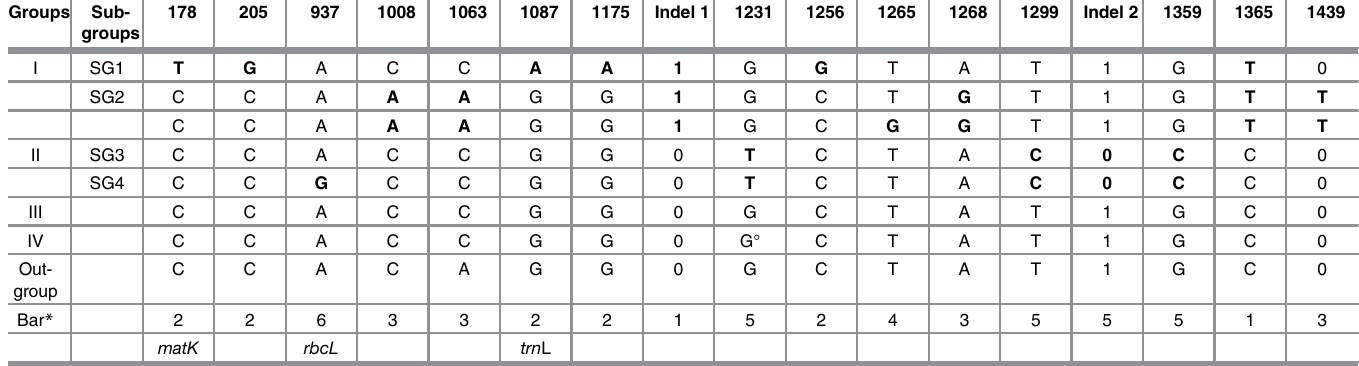
Table 2. Diagnostic polymorphisms for the identification of Malagasy Dalbergia based on DNA sequence variation in the plastid genes mat K, rbc L and trn L (UAA). In bold are diagnostic polymorphisms that distinguish Malagasy from non-Malagasy Dalbergia . Groups Sub-